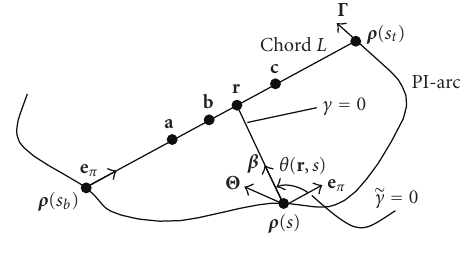
Figure 3: Variable change from γ to (cid:7) γ .